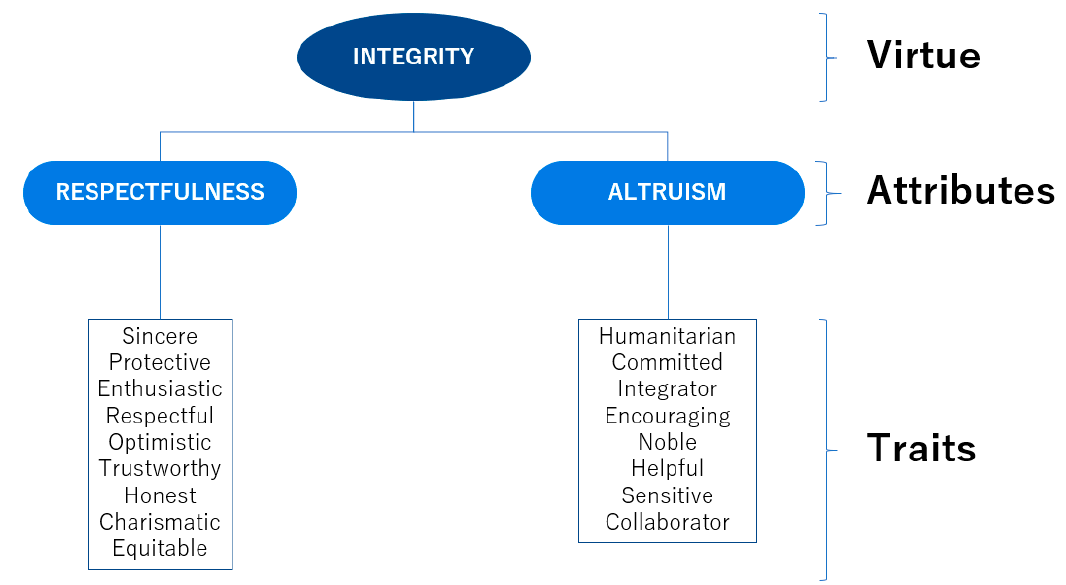
Figure 3. Updated structure of the SRBP dimension in times of COVID-19.